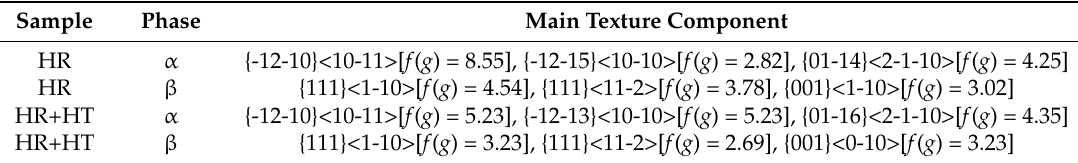
Table 2. Main texture components for the α and β phases of HR and HR+HT samples.